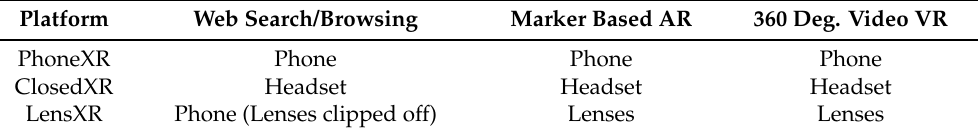
Table 2. The three platforms and applications tested in the assessment of multitasking XR and non-XR applications. Platform Web Search/Browsing Marker Based AR 360 Deg. Video VR PhoneXR Phone Phone Phone ClosedXR Headset Headset Headset LensXR Phone (Lenses clipped off) Lenses